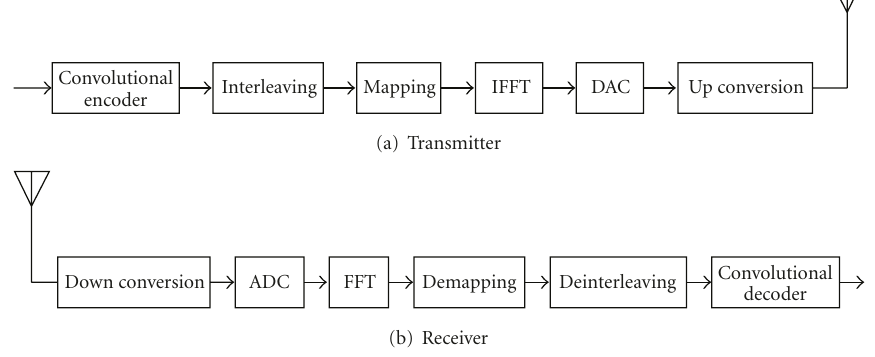
Figure 4: Conventional 802.11a (a) transmitter and (b) receiver.